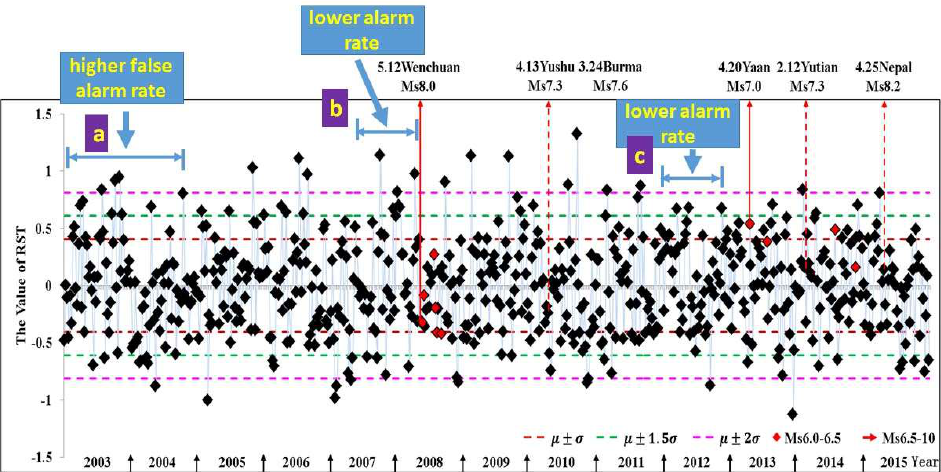
Figure 21. Tectonic TIR anomalies in time series extracted by the RST method in Longmenshan Fault.